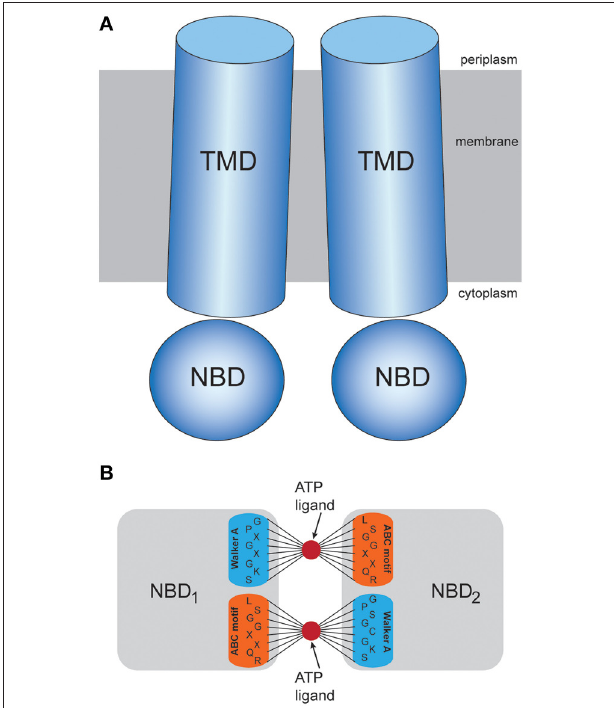
FIGURE 1 | Transporter structure and modeling scheme. (A) Schematic representation of the domain organization in ABC transporters. (B) Illustration of the proposed coarse-grained ligand interaction scheme. An ATP-mimicking ligand bead is placed in the center of each nucleotide binding pocket, where it is bound to beads of the Walker A and ABC residue motifs via stretched elastic